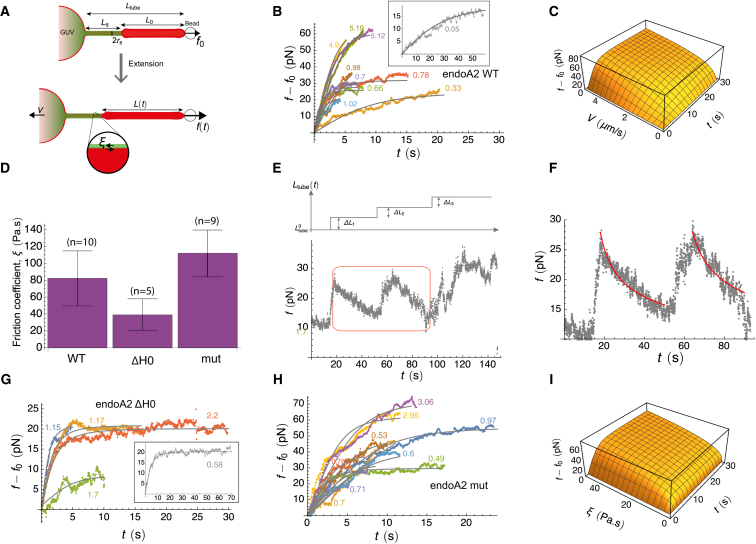
Extending Endophilin-Coated Tubes Leads to Force Increase(A) Illustration of a protein-scaffolded tube extended at speed V. Relative motion between scaffold (green) and membrane tube (red) results in friction, with coefficient ξ, and an increase in force f.(B) Force versus time for WT endophilin-coated tubes, pulled at a constant speed V, for ten vesicles. Each dataset is fitted with Equation 3 for the given value V (as labeled, given in micrometers per second). For clarity, the initial force f0 has been subtracted. Inset: scission of a vesicle pulled at the lowest speed occurs on a longer timescale and is shown separately.(C) 3D plot of f versus t and V, calculated from Equation 3, showing the increase of force with pulling speed, all other parameters remaining constant (f0 = 2 pN, L0 = 0.8 μm, and ξ = 30 Pa.s).(D) Bar graph comparing the mean friction coefficient ξ for endoA2 WT, endoA2 ΔH0, and endo mut (error bars indicate SEM). Average values are ξ=80± 30 Pa.s (endoA2 WT), ξ=39±19 Pa.s (endoA2 ΔH0), and ξ=112±27 Pa.s (endoA2 mut).(E) Force after a sudden increase in tube length. Relaxation of the force occurs following two length jumps, ΔL1 = 3 μm and ΔL2=4 μm.(F) Fits to the force relaxation after the two steps (red boxed region in H) yield ξ=35±0.8 Pa.s and ξ≈73±2 Pa.s (95% confidence limit [CL]). The total bare length was estimated as L=4.95 μm (obtained by integrating (d/dt)(L/f)=0 across the step) after the first step and L=8.6 μm after the second one. The relaxation data were fitted numerically by solving Equation 2. The bending stiffness of the membrane was taken to be κ=45kBT for all fits (Simunovic et al., 2016).(G) Force versus time endoA2 ΔH0-coated tubes, pulled at a constant speed (n = 5). Inset: scission of a vesicle pulled at the lowest speed occurs on a longer timescale and is shown separately.(H) Force versus time endoA2 mut-coated tubes, pulled at a constant speed (n = 9).(I) 3D plot of f versus t and ξ, calculated from Equation 3, showing the increase of force with friction, all other parameters remaining constant (V = 2 μm.s−1, f0 = 4 pN L0 = 0.8 μm).See also Figure S4.